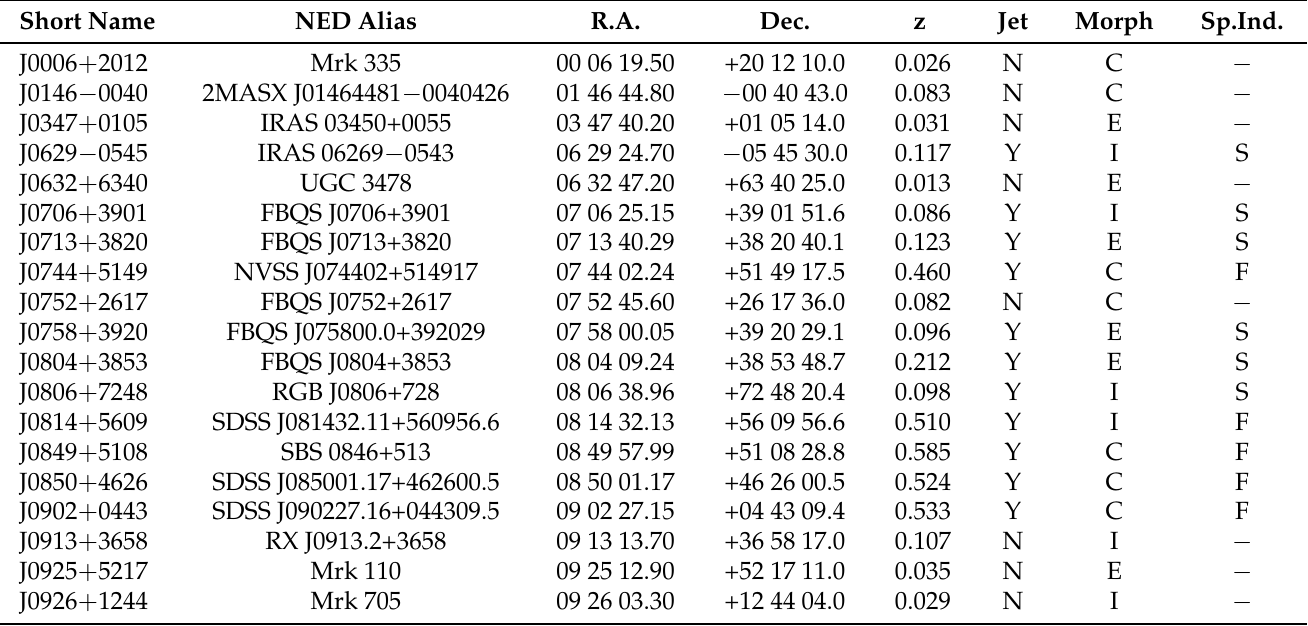
Table 4. Sample studied in this work. Columns: (1) short name; (2) NED alias; (3) right ascension; (4) declination; (5) redshift; (6) jet (Y stands for yes, N for no); (7) radio morphology (C stands for compact, I for intermediate, E for extended); (8) spectral index for jetted sources (F stands for flat spectrum, S stands for steep